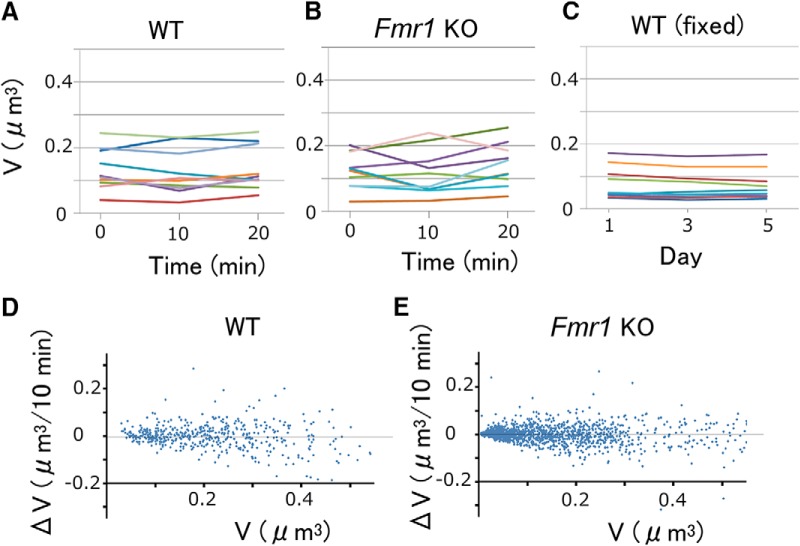
Fast volume changes in apical dendritic spines in the mouse visual cortex. A, B, Spine-head volume changes in WT (A) and KO (B) mice measured at an interval of 10 min. C, Spine-head volume changes in a fixed sample imaged at an interval of 2 d. D, E, Head volume changes (ΔV) per 10 min in WT (D) and Fmr1 KO (E) mice. Data were obtained from 475 spines from two dendrites in two WT mice, and from 1433 spines from four dendrites in three KO mice.